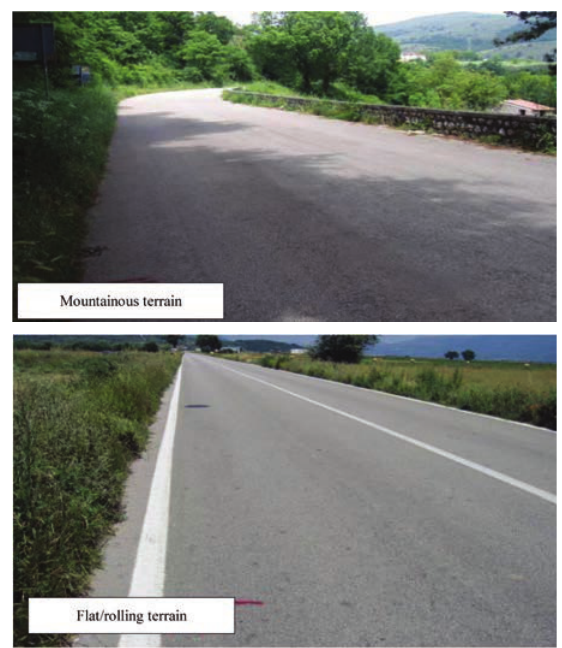
Fig. 1. Photographs of a typical road located on the mountainous and flat/rolling area